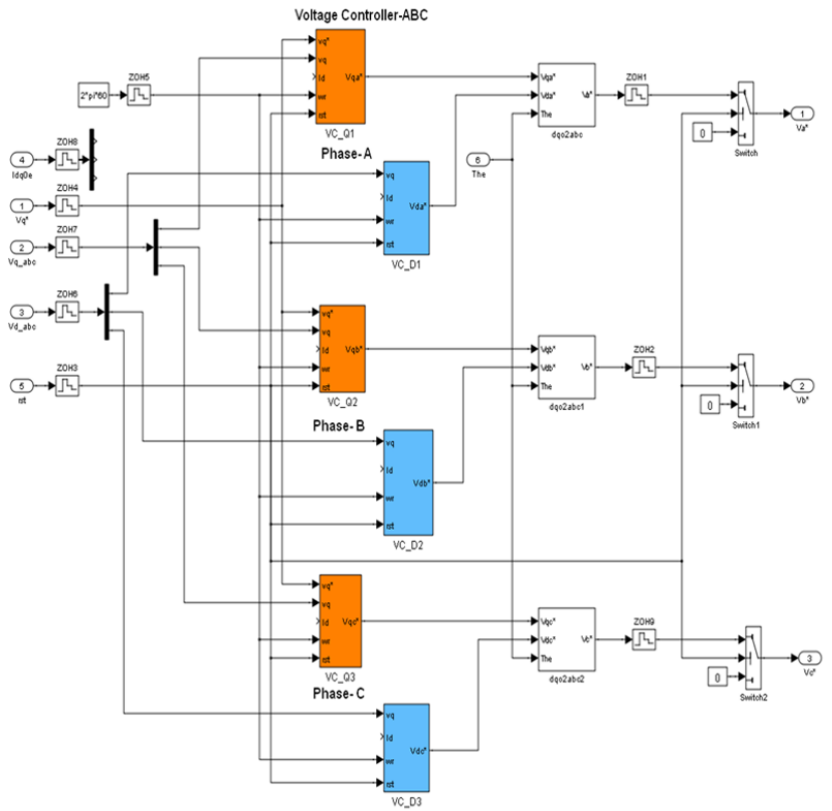
Figure 6. Modeling of single-phase voltage controller.